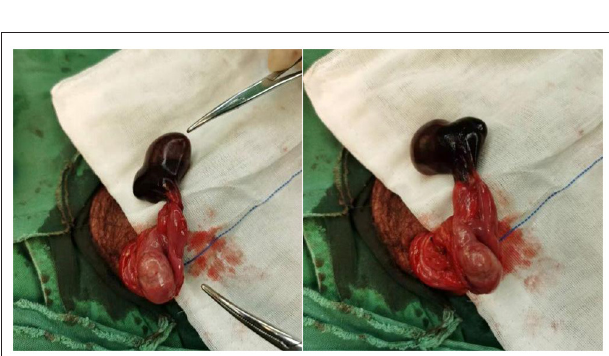
FIGURE 2 | Emergency scrotal exploration was performed; the upper left testicle was black and twisted 360 ◦ clockwise. The lower left testicle was normal in its